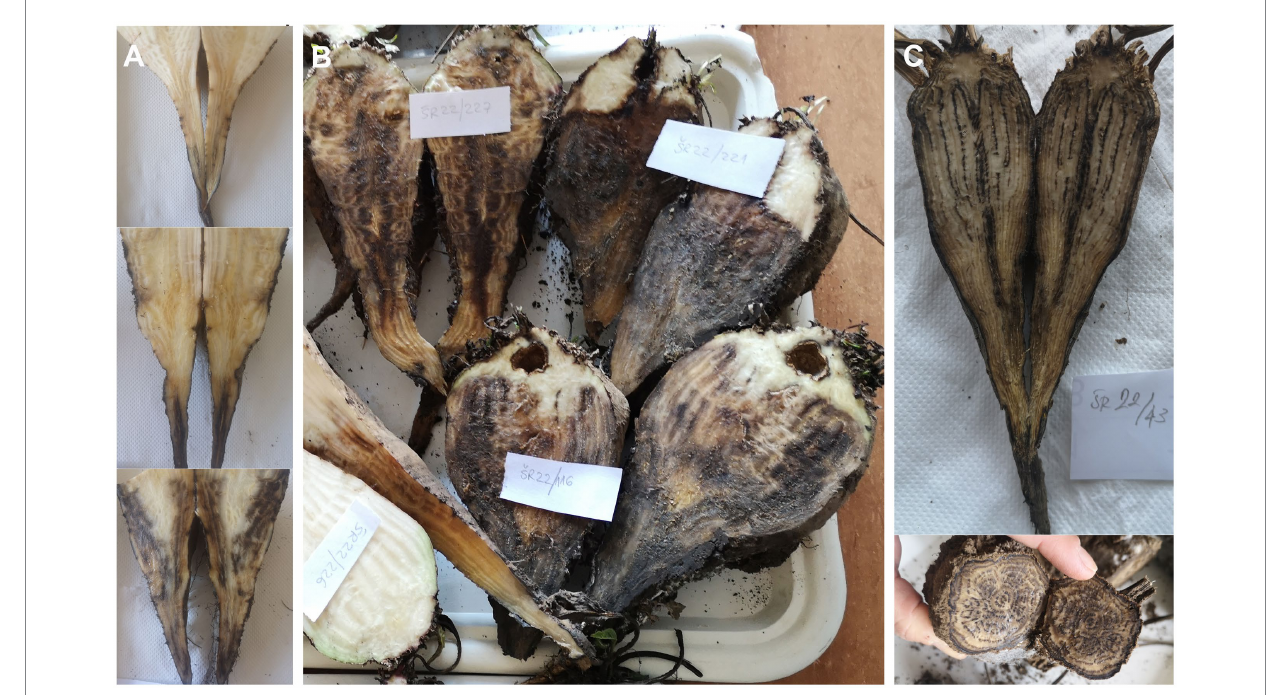
FIGURE 1 Cross section of sugar beet infected with ‘ Candidatus Phytoplasma solani’ and Macrophomina phaseolina . (A) Early stage of charcoal root rot beginning from root tail; (B) Different stages of charcoal root rot; and (C) Advanced stage of charcoal root rot.